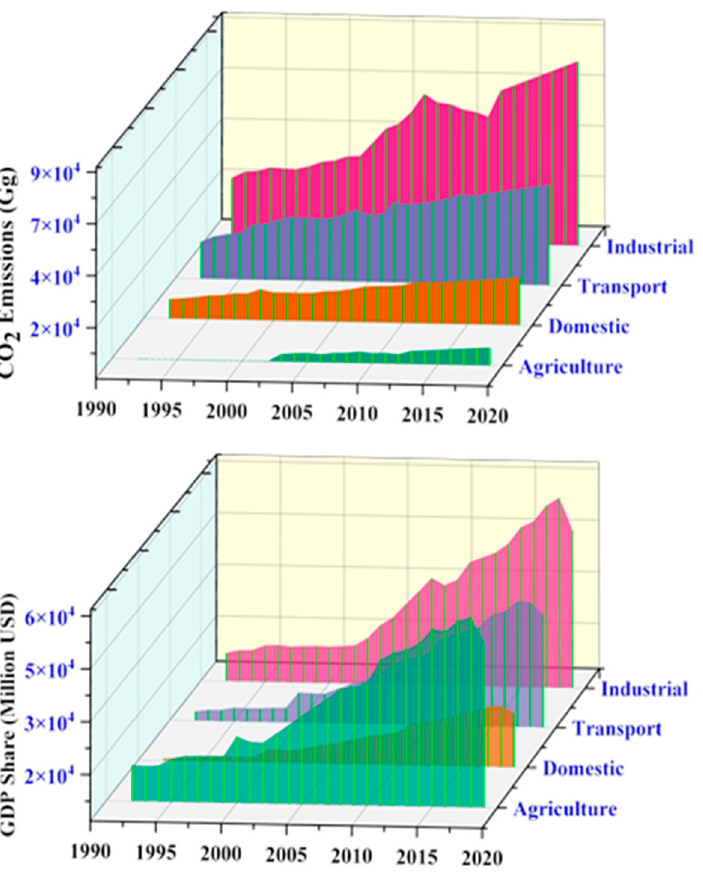
Figure 6. Sectoral GDP, CO 2 emissions and Energy consumption in Pakistan .